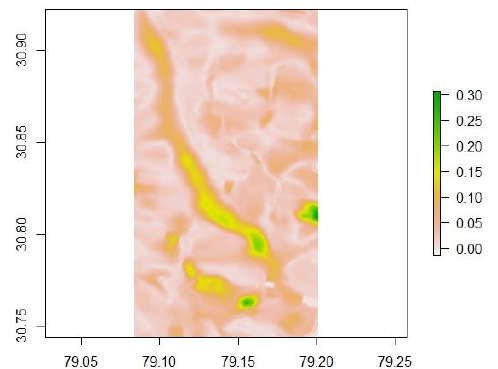
Figure 7: Gangotri glacier velocity map using descending pass TerraSAR-X images (03 June 2012 and 25 June 2012) (Figure scale in m day -1 ).